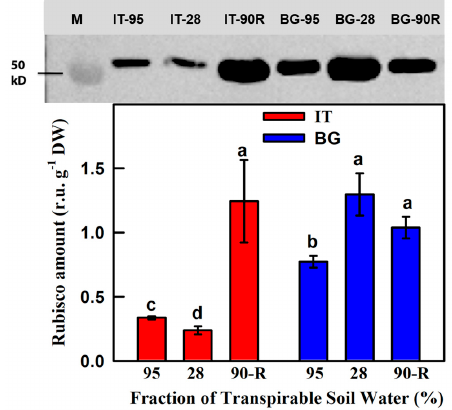
Figure 3. Rubisco protein content in Italian (IT, red bars) and Bulgarian (BG, blue bars) populations of P. orientalis plants under control (FTSW = 95%) and drought (FTSW = 28%) conditions and after re-watering (FTSW = 90%R). Rubisco protein bands were normalized to the Actin band. Data are means ± SE of six independent samples. Statistically significant differences (Tukey’s test, p < 0.05) between the IT and BG populations are indicated by different letters.